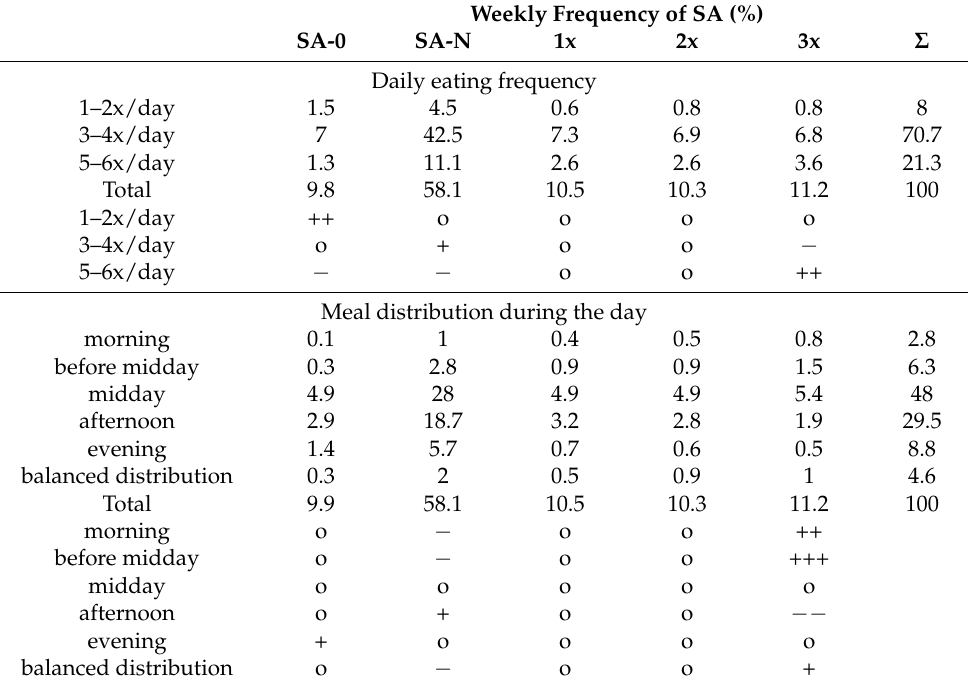
Table 5. Relation between daily eating frequency, meal distribution, and frequency of SA.